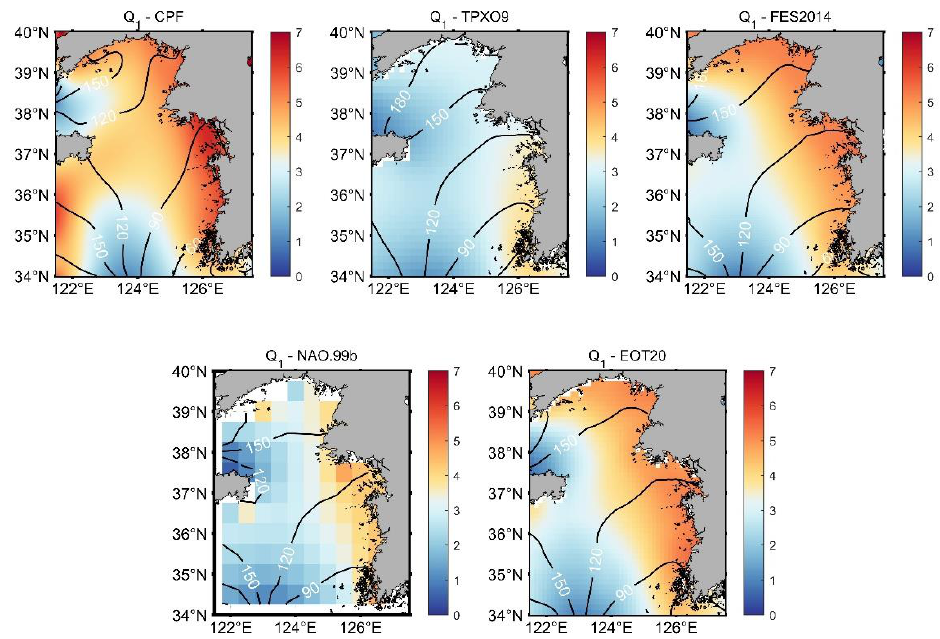
Figure 12. The cotidal charts of the Q 1 constituent from the CPF method and the TPXO9, FES2014, NAO.99b and EOT20 models (unit: cm).